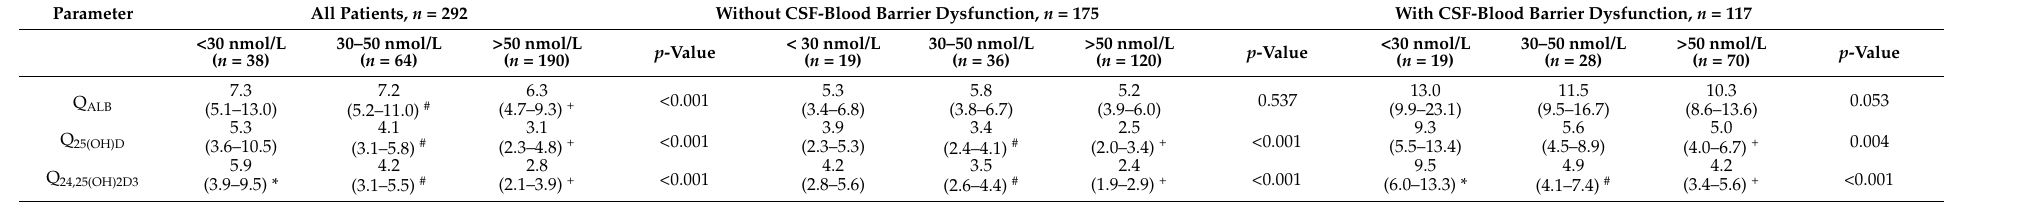
Table 3. CSF concentrations of vitamin D metabolites according to tertiles of 25(OH)D serum